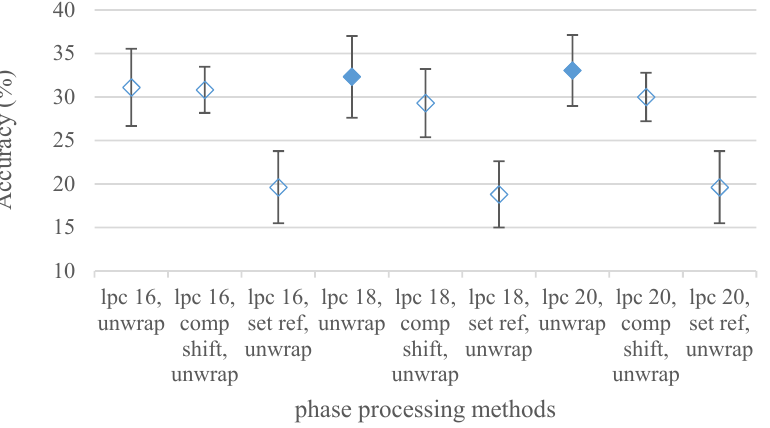
Figure 19. Averaged accuracies and standard deviations for phase spectrograms using following modifications: unwrap, unwrap and set reference phase, and unwrap and shift compensation in the case of an 8 kHz frequency limit and LPC model orders (lpc): 16, 18, and 20. Filled marks show equally performing settings.